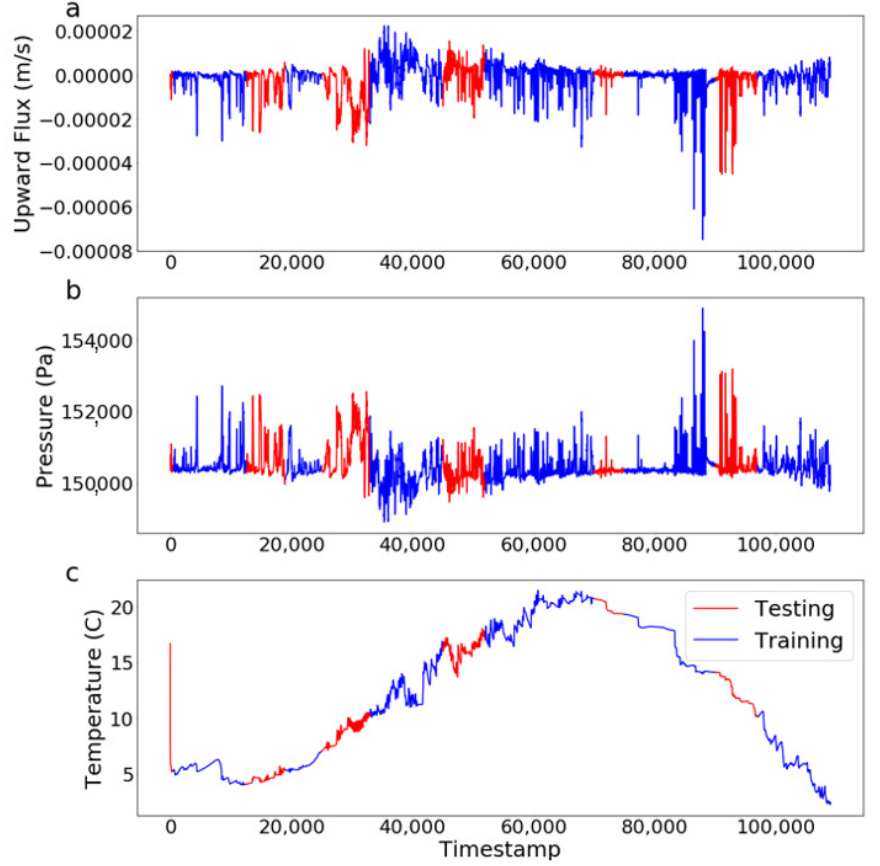
Figure 4. Time series of training (blue) and testing (red) sets illustrated using data from 0.005 m depth. ( a ) upward flux, ( b ) pressure, and ( c ) temperature.